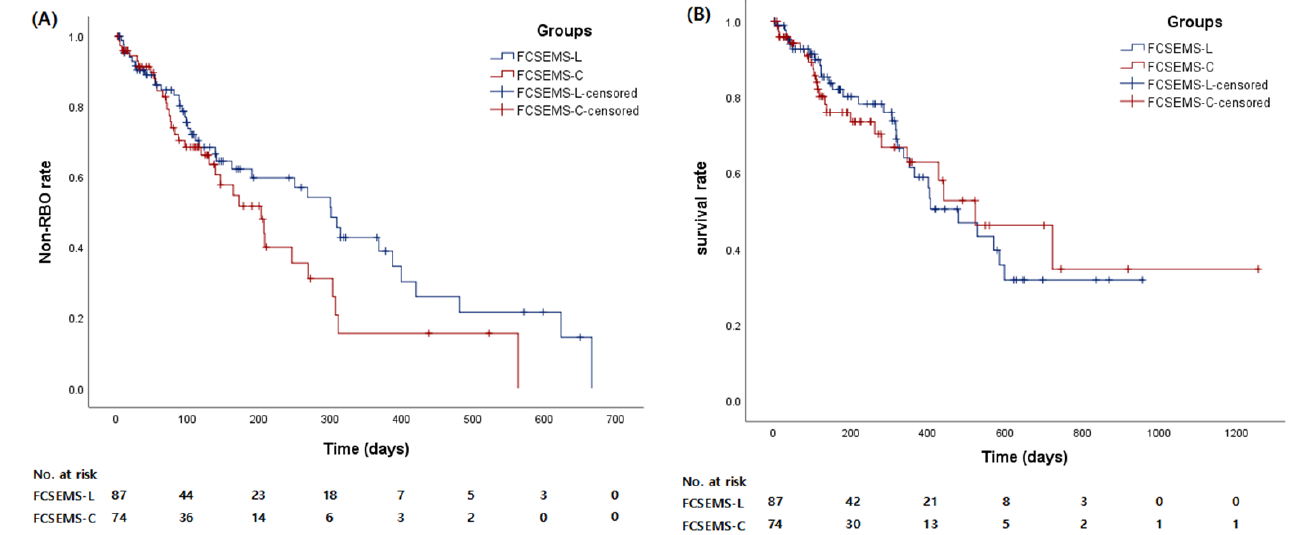
Figure 3. Time to recurrent biliary obstruction (RBO) and patient survival time in the FCSEMS-L and FCSEMS-C groups. ( A ) Time to RBO. ( B ) Patient survival time.